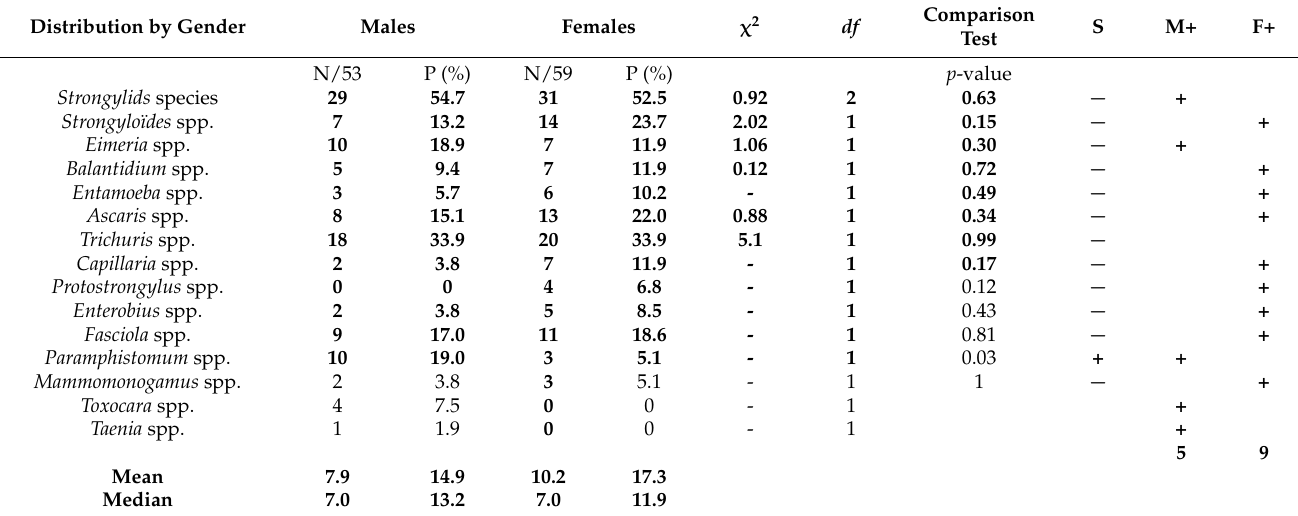
Table 4. Distribution and prevalence of parasite species reported to the gender.